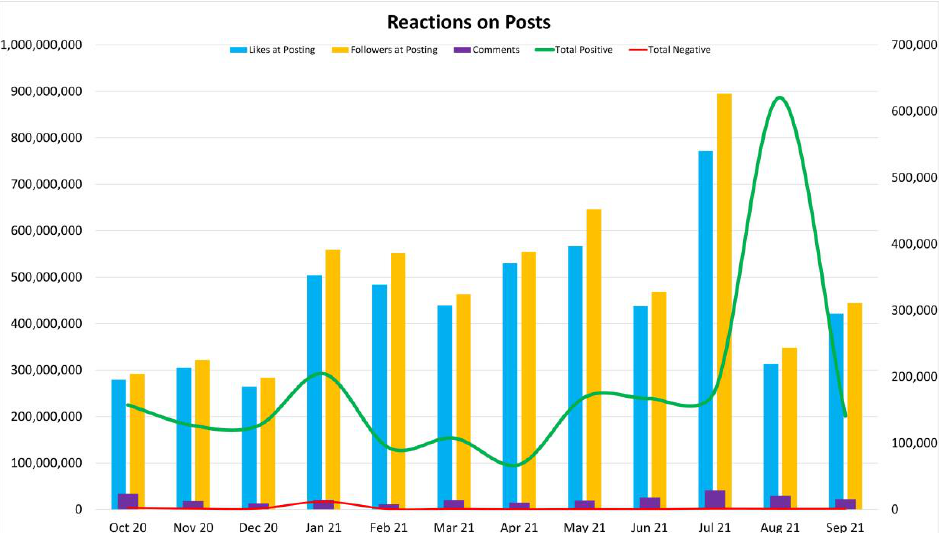
Figure 2 Figure 2. Reactions on posts. Digital representation of reactions on messages on Facebook pages and groups. Reactions on health posts increased slowly, whereas negative sentiments decreased over time, as shown in Figure